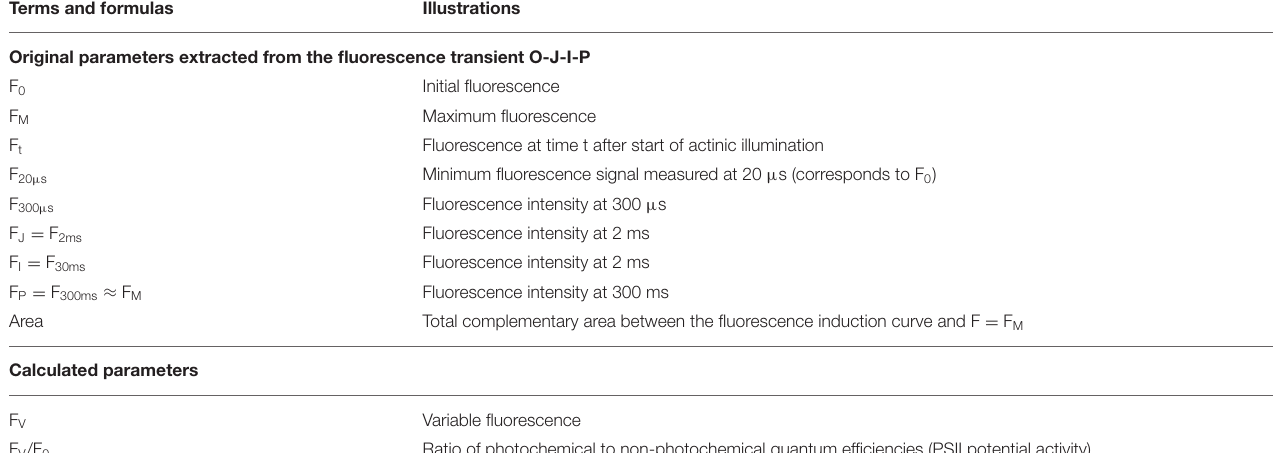
TABLE 1 | Selected JIP parameters from analysis of the OJIP curves used in the analysis of Brosimum gaudichaudii seedlings grown in vitro under different LED spectra for 50 days. Terms and